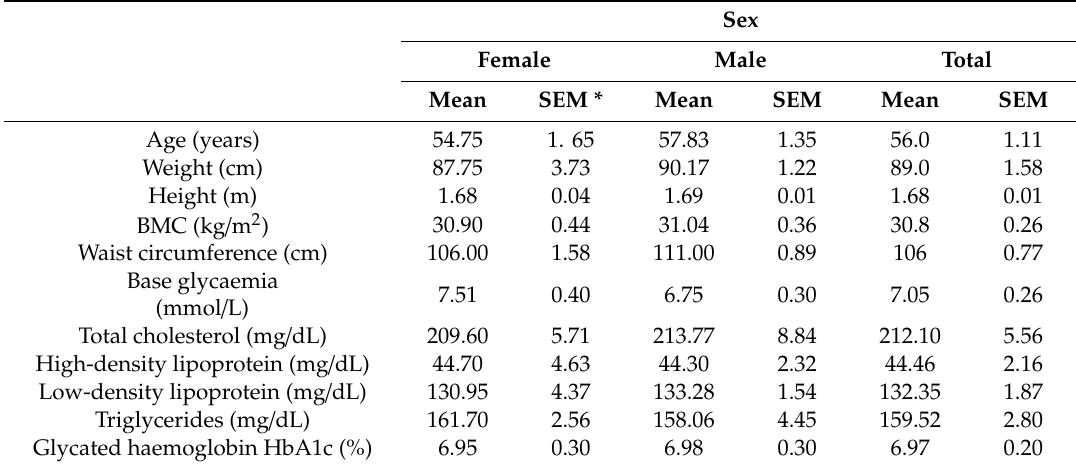
Table 3. General characteristics of the enrolled patients.